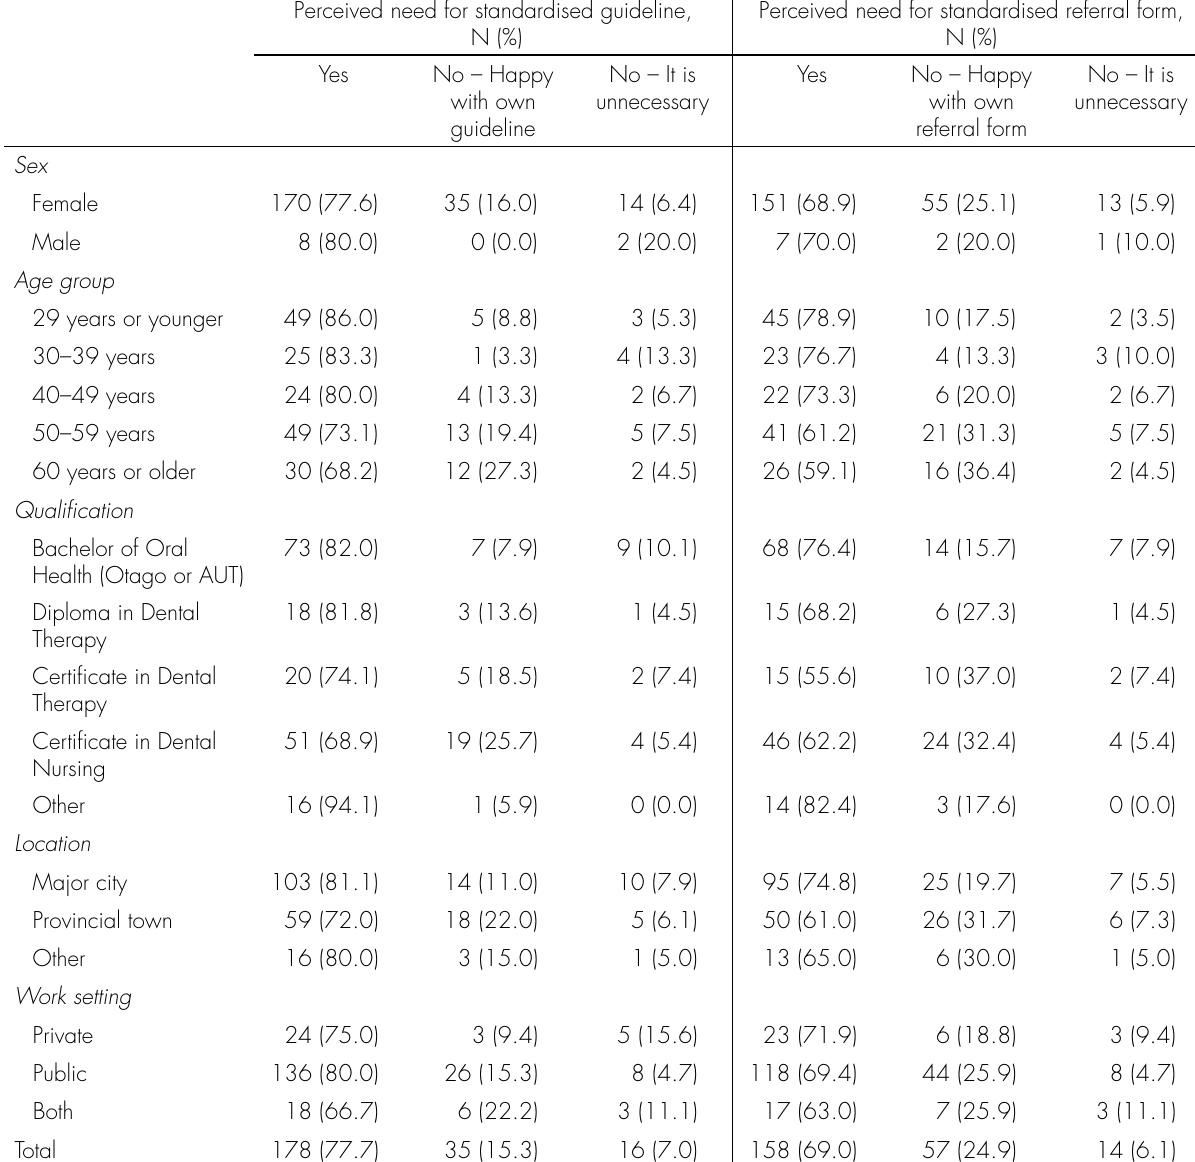
Table V. Perceived need for a standardised orthodontic guideline and standardised orthodontic referral form by demographic Perceived need for standardised guideline, Perceived need for standardised referral form, N (%) N (%)